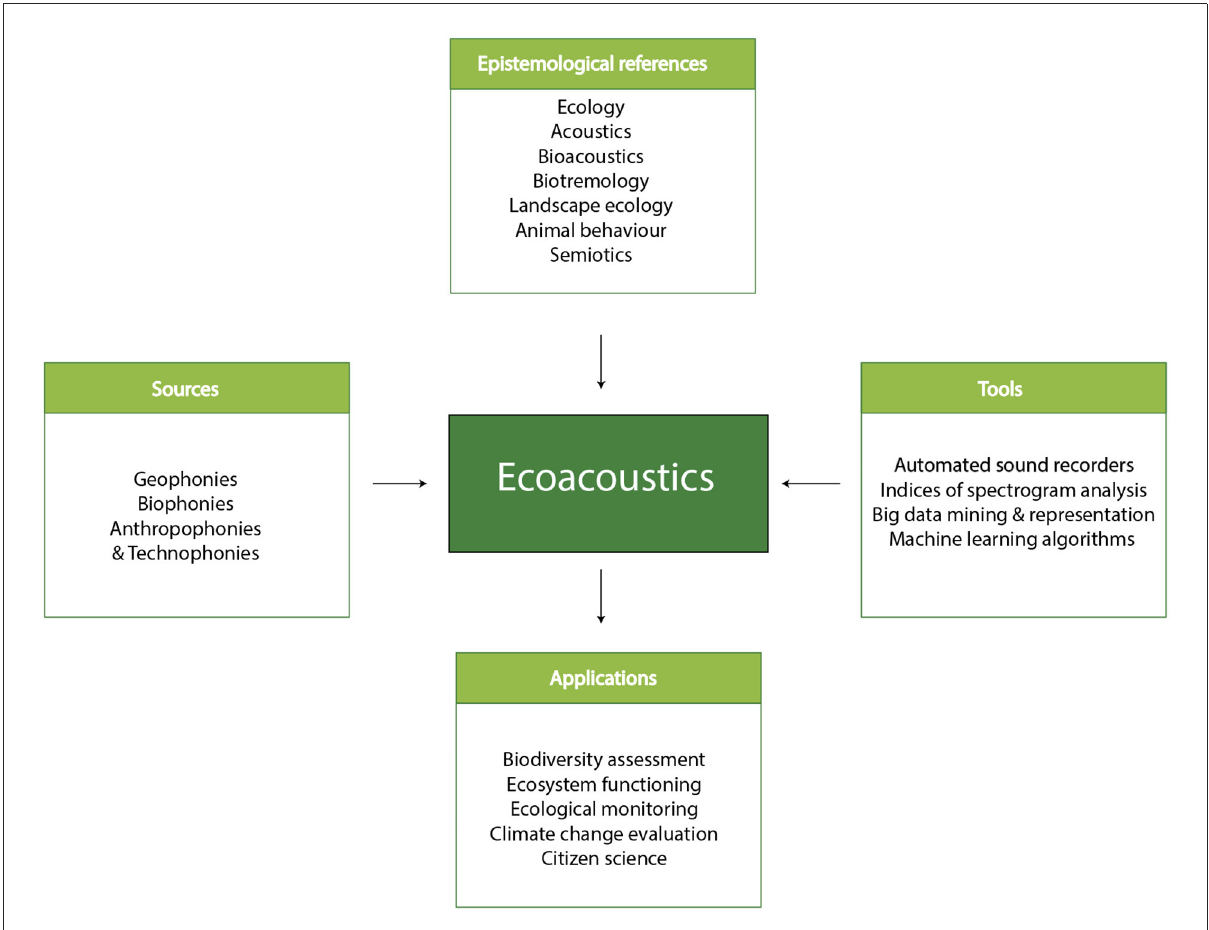
FIGURE1 Ecoacoustics epistemological domain and